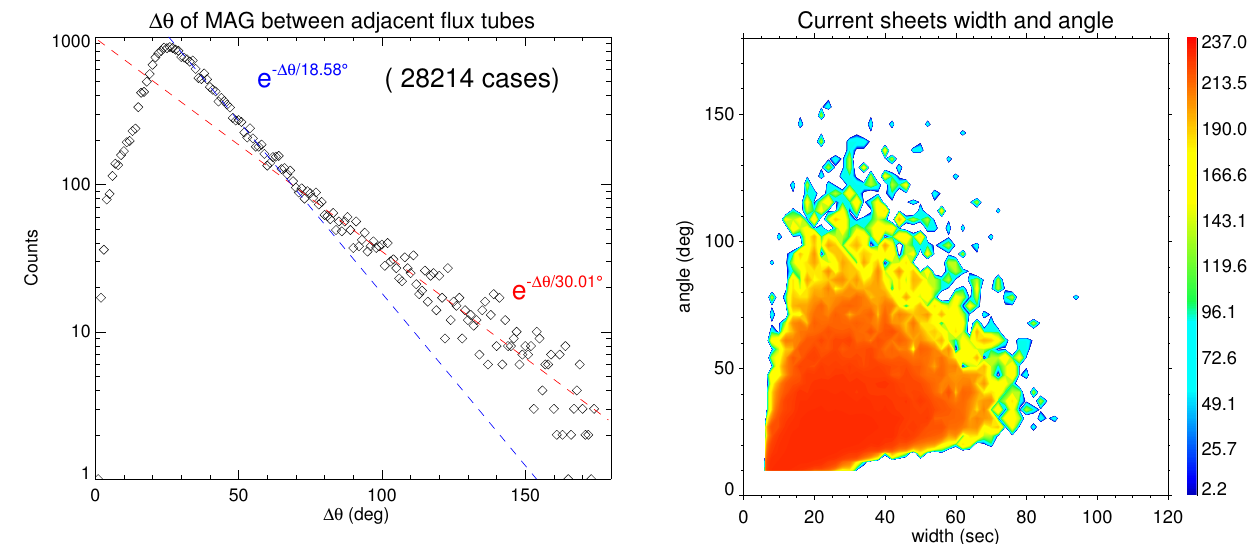
Fig. 8. The correlation of the width of current sheets and angle between the magnetic field of adjacent flux tube. In the left part, the ◦ y-axis is the 1θ( deg ) , and the x-axis is the width (s). The colors in , A 2 is a the left part are the counts of current sheet occurrences. The pattern is smoothed by the